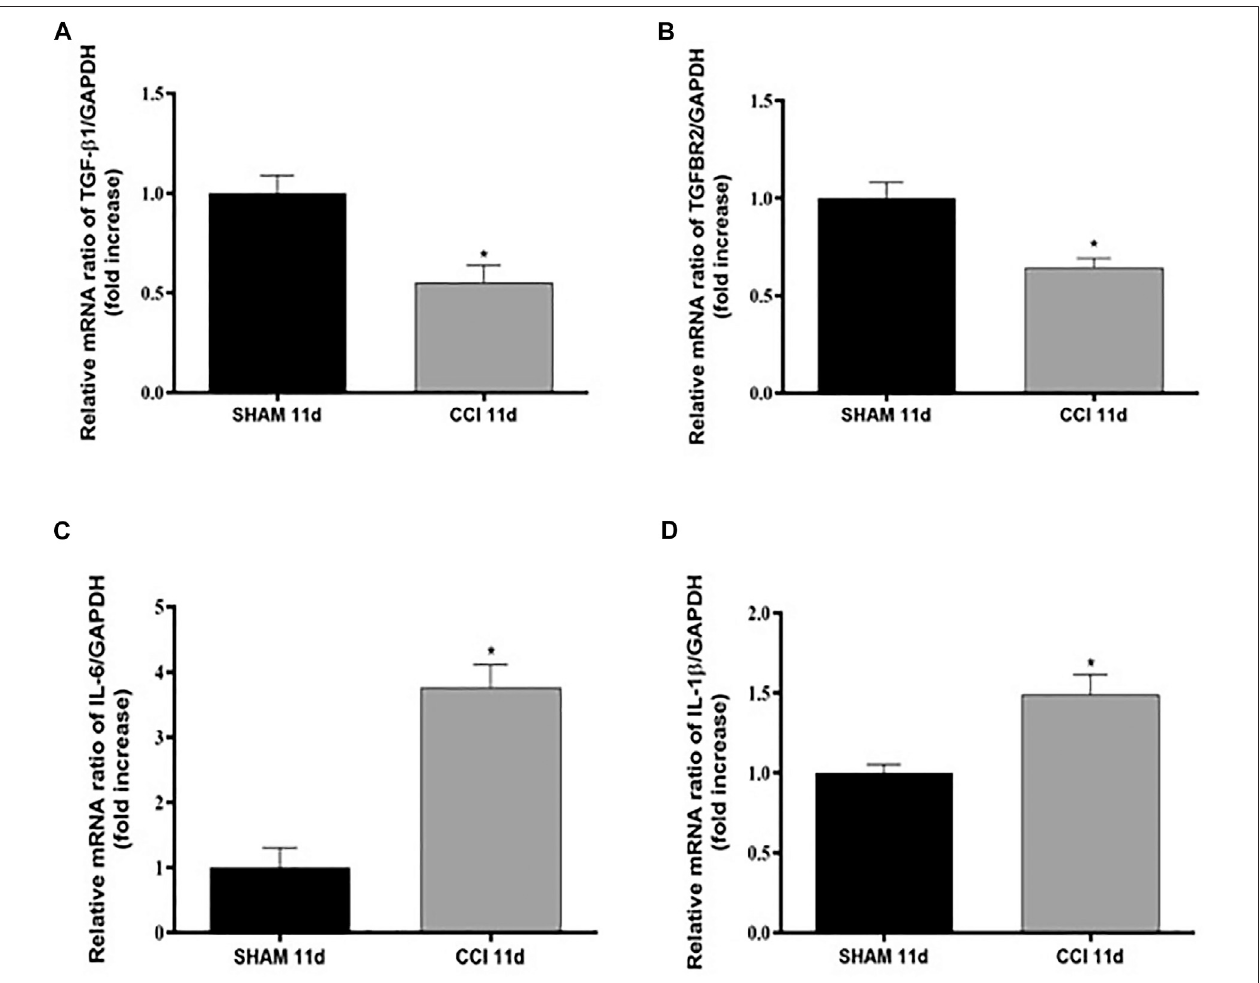
FIGURE2| CCIincreasespro-in fl ammatorycytokineslevelsandreducesTGF- β 1levels11dpl.Measurementof (A) TGF- β 1(t (cid:1) 3,593,df (cid:1) 4;F,DFn,Dfd (cid:1) 1,031, 2,2), (B) TGF β -R2(t (cid:1) 3,761,df (cid:1) 4;F,DFn,Dfd (cid:1) 3,027,2,2), (C) IL-6(t (cid:1) 5,955,df (cid:1) 6;F,DFn,Dfd (cid:1) 1,332,3,3),and (D) IL-1 β (t (cid:1) 3,206,df (cid:1) 5;F,DFn,Dfd (cid:1) 6,952,3, 2) mRNA expression levels (RT-qPCR) in spinal cord of SHAM or CCI rats after 11 days. The abundance of each mRNA of interest was expressed relative to the abundance ofGAPDH mRNA, asan internal control. Data areshown asmean ± SEMof n (cid:1) 3 – 4rats per group. Statistical analysis wasperformed using Student ’ s t-test. * p < 0.05 vs.